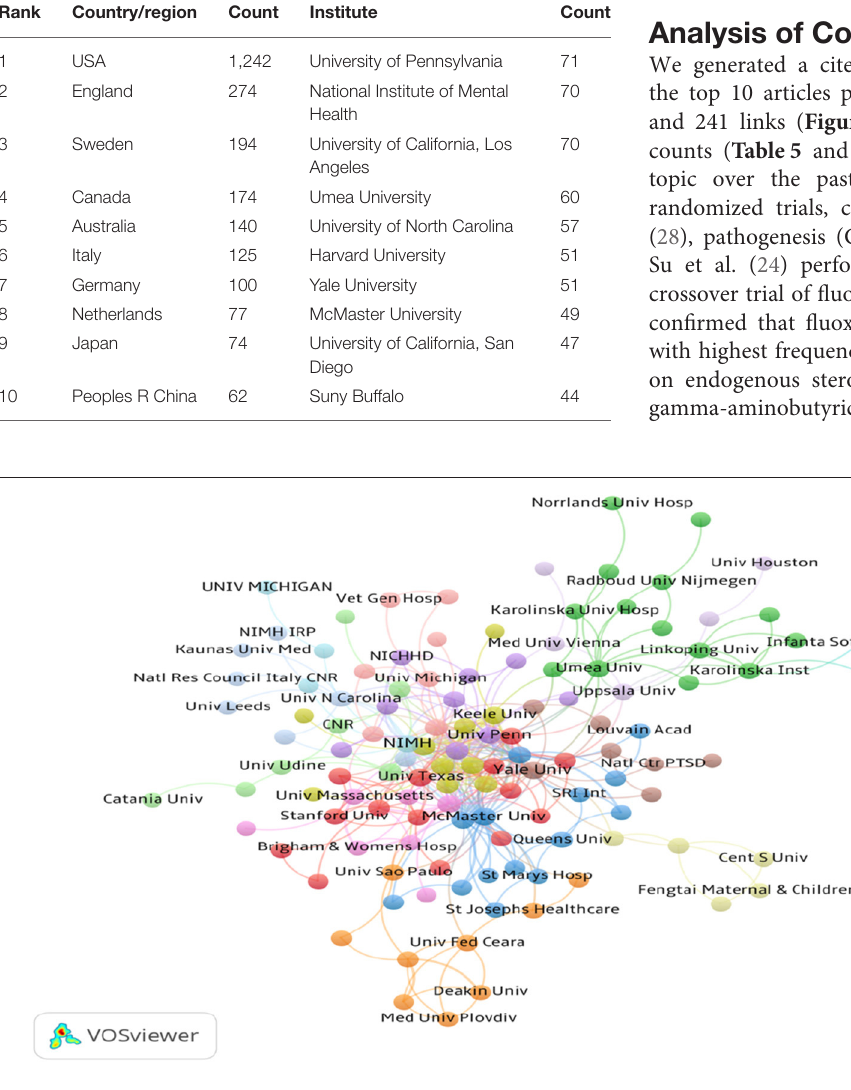
FIGURE 5 | Map of institutions that published articles on PMS/PMDD during 1945–2018.